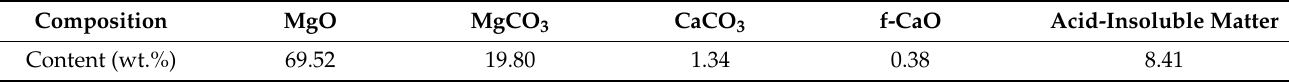
Table 2. Chemical composition of light-burned magnesia.